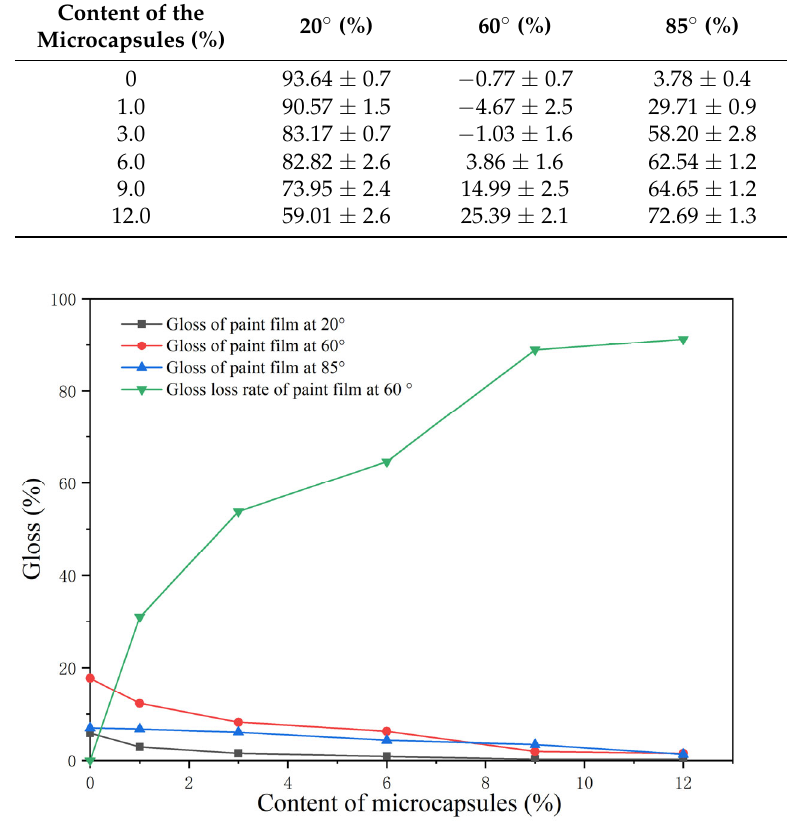
Figure 15. The trend of the gloss and gloss loss rate of the paint films. As shown in Figure 16, the transmittance of the paint film was negatively correlated with the loading of the aloe ‐ emodin microcapsules. The higher the loading, the lower the transmittance. This occurred because the microcapsules were yellow and opaque, and adding them to the transparent water ‐ based coating affected the light transmittance. film with the microcapsules was far lower than that without the microcapsules, and the transmittance reached the lowest value at 430 nm. This occurred because the paint films with microcapsules were yellow, while purple and blue are the complementary colors of yellow. The wavelength range was respectively between 400–450 nm and 450–480 nm. When the visible light passed through the paint films, the purple light and blue light were absorbed, and the remaining light intensity was significantly lower than the inci ‐ dent light intensity, so the transmittance in this wave band was very low. Figure 16. The trend of the transmittance of the paint films.